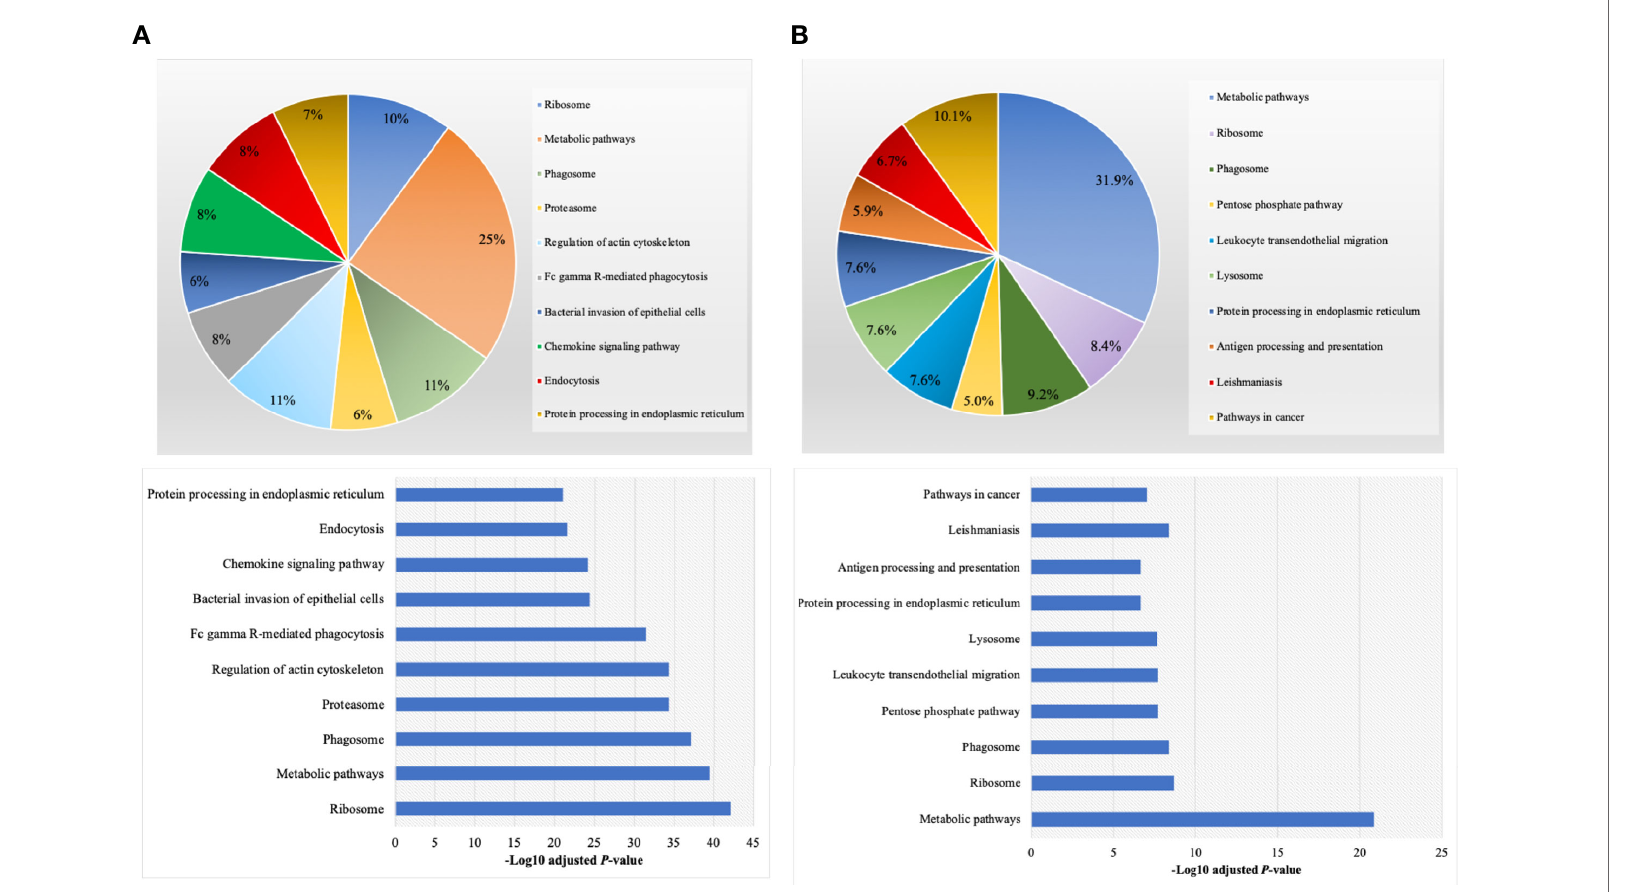
FIGURE 4 | KEGG pathway enrichment analysis of (A) non-differentially expressed and (B) differentially expressed proteins listed on their percentage (upper panel) and level of signi fi cance (lower